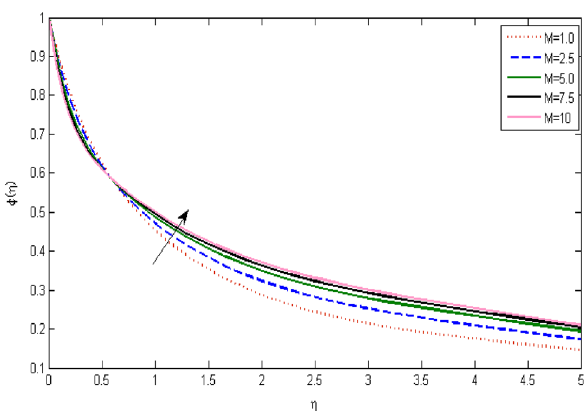
Figure 3. M influence on ϕ .